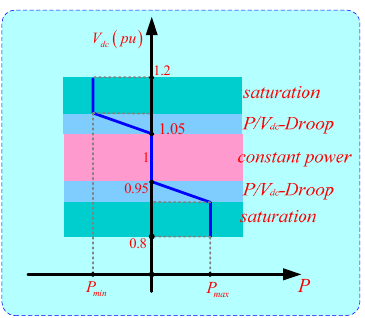
Figure 5. Schematic diagram of the proposed P / V DC droop control.